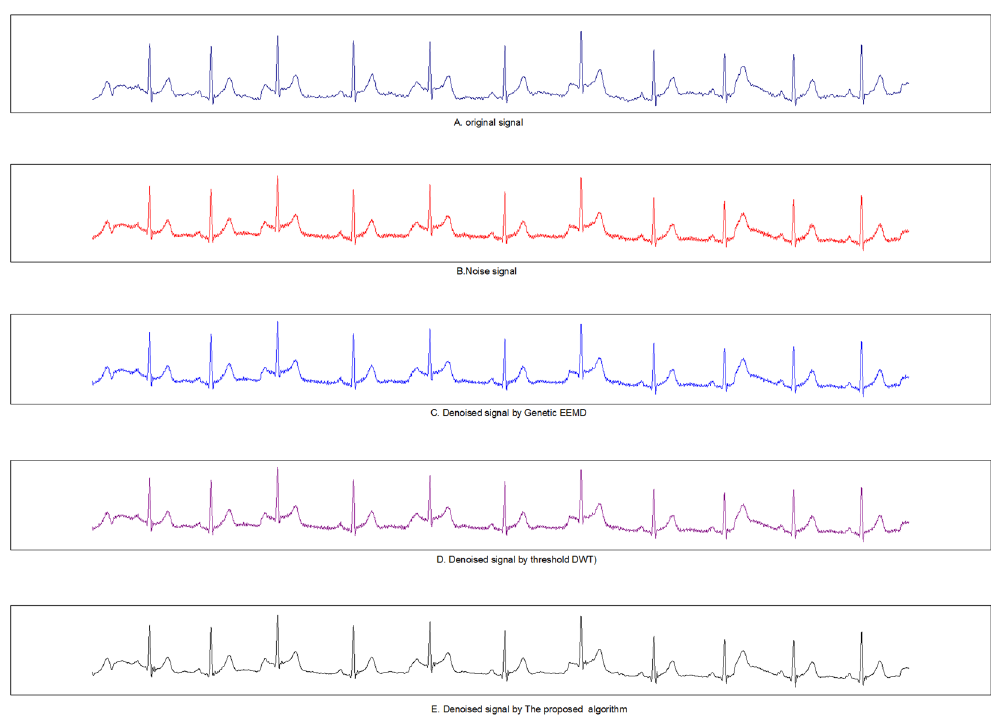
Figure 10. Comparison of denoising results with different denoising algorithms. A is the original ECG, B is the ECG containing noise, C is the ECG after processed by Threshold DWT, D is the ECG processed by Genetic EEMD, and E is the ECG processed by the algorithm in the